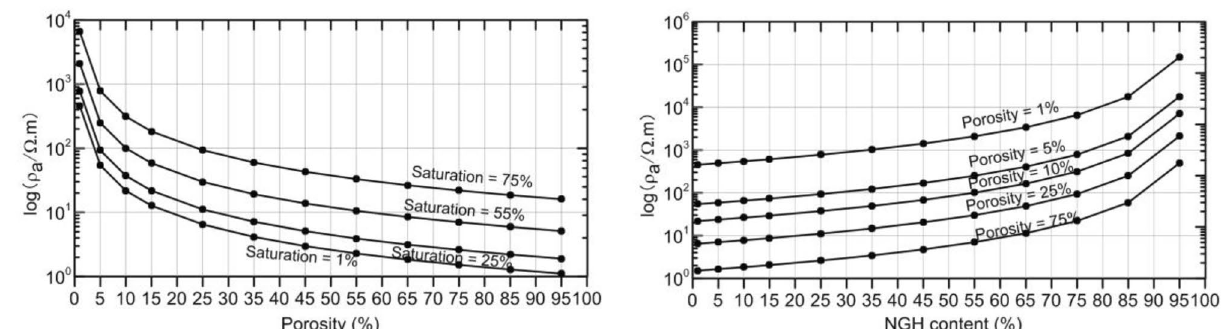
Figure 6. Resistivity as a function of porosity (left) and NGH saturation